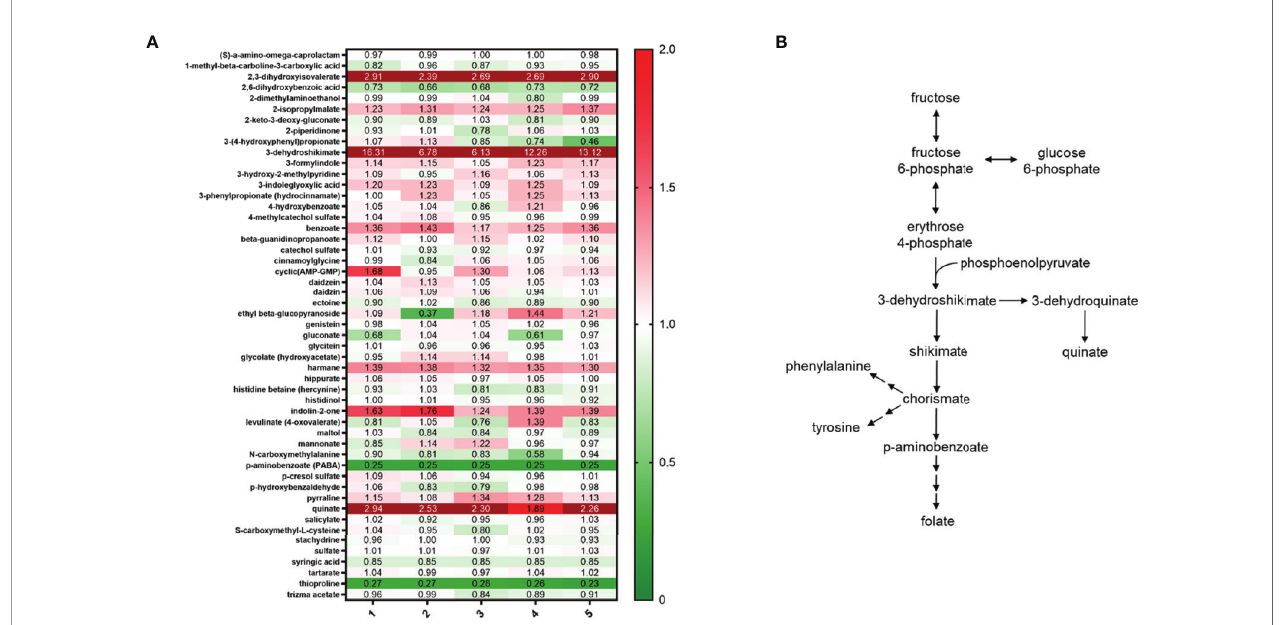
FIGURE 6 | S. parasanguinis increases RNS scavengers and aromatic compounds in response to nitrite. (A) Heatmap of RNS scavengers and xenobiotic metabolites (values are median normalized). (B) Metabolic pathway for aromatic compounds. All cultures were grown for 16 hours in TSBYE and 1% sucrose in 5% CO 2 . Metabolomics data were collected for 5 replicates in each